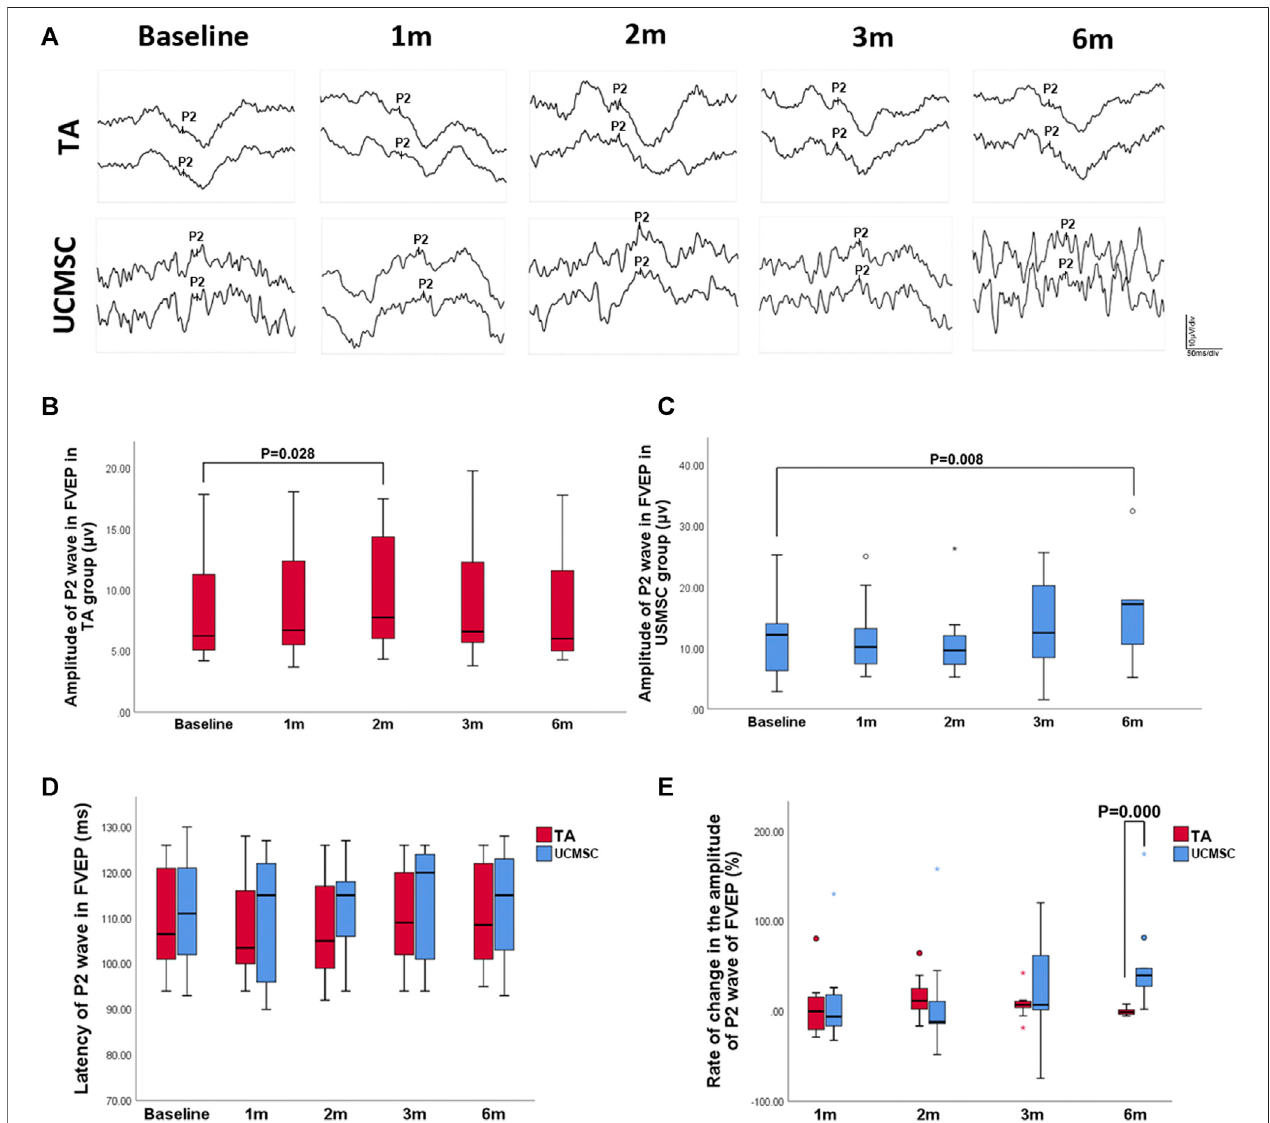
FIGURE 5 | Assessments of FVEP. (A, B) In the TA injection group, the amplitude of P2 wave in FVEP signi fi cantly increased at second month ( p (cid:2) 0.028, n (cid:2) 20, Wilcoxon signed-rank test). (A, C) In UCMSCs infusion group, the amplitude of P2 wave showed a signi fi cantly increase at sixth month ( p (cid:2) 0.008, n (cid:2) 20, Wilcoxon signed-ranktest). (D) Therewerenosigni fi cantdifferencesoflatencyofP2waveamongfollowupswithineachgrouporbetweenthetwogroups( p > 0.05). (E) TheROC in amplitude of P2 wave in UCMSCs group was signi fi cantly higher than that of TA group at sixth month ( p (cid:2) 0.000, n (cid:2) 20, Mann – Whitney U test).